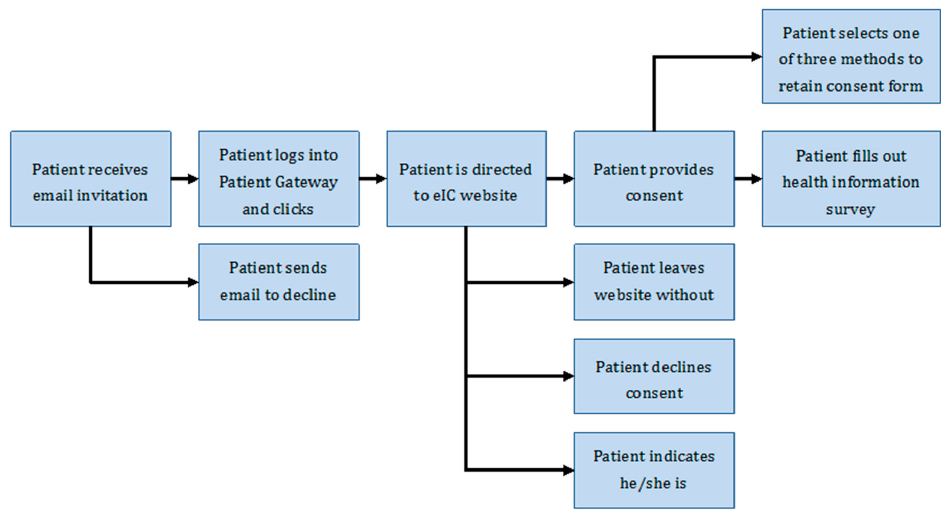
Figure 2. Overview of workflow for eIC at the Partners Biobank.